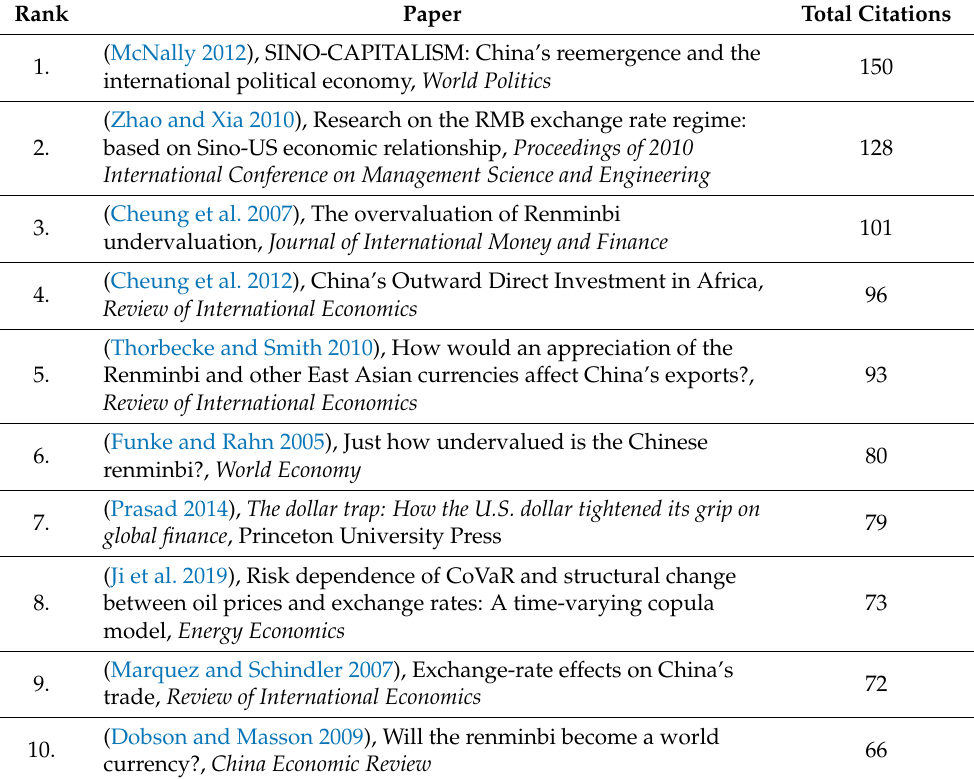
Table 3. Top 10 cited papers by global